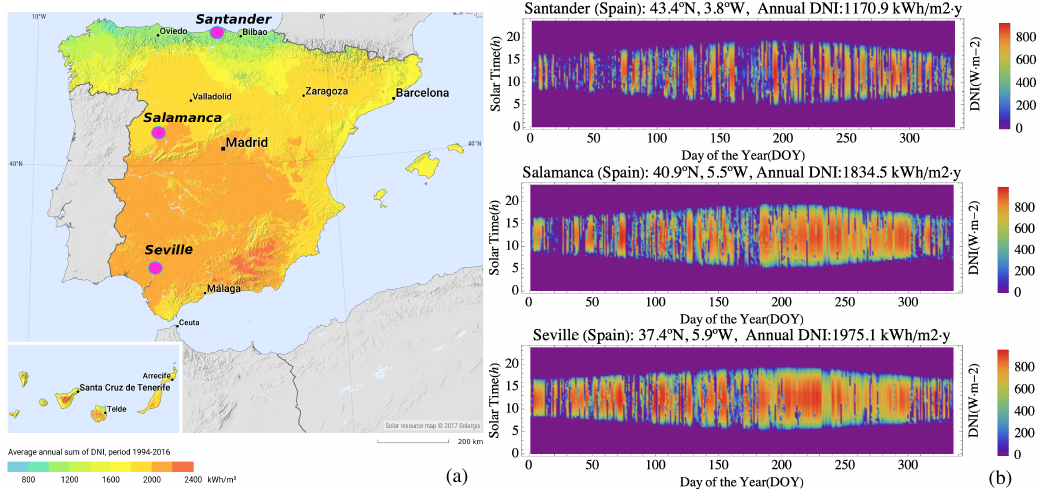
Figure 3. ( a ) Map of the average annual sum of the Direct Normal Irradiation (DNI) in kWh/m 2 in Spain in the period 1994–2016 [44]. The location of the selected cities is indicated on the map. ( b ) Annual DNI map from December 2017 until November 2018 in Salamanca, Santander, and Seville [45]. The annual DNI accumulated during this period is indicated above the figure for each